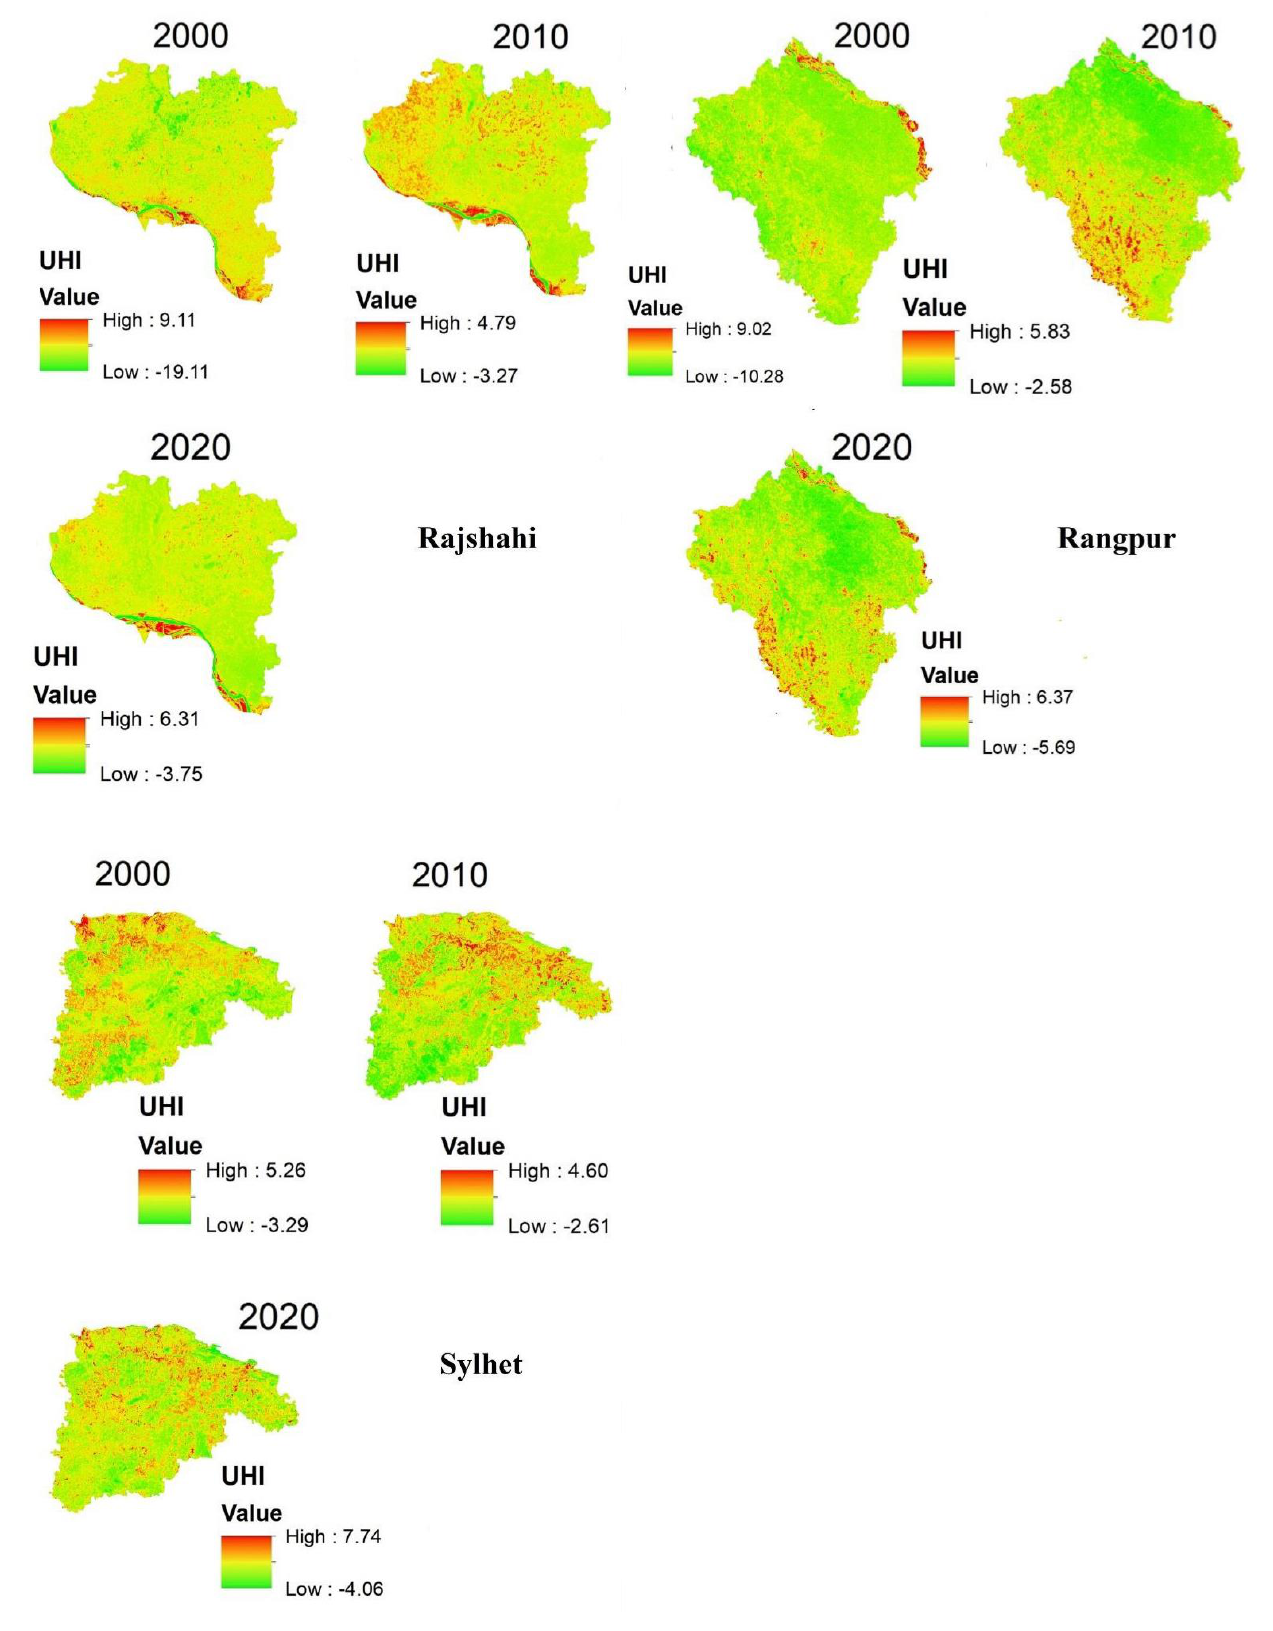
Figure 9. Spatiotemporal distributions of UHI intensity in seven districts of Bangladesh during 2000 – 2020.